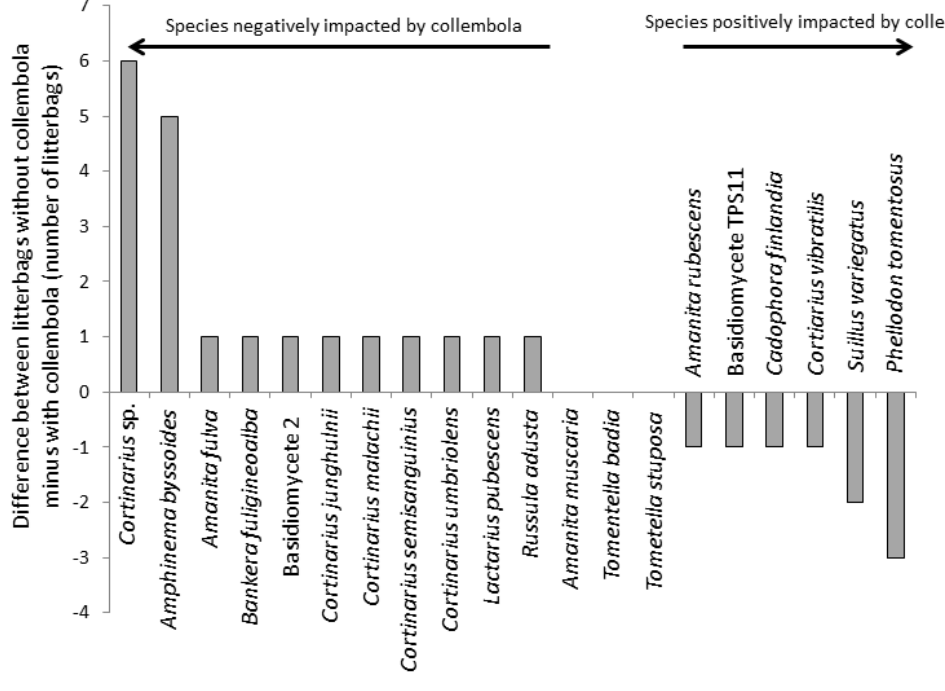
Figure 3. Response of ECM fungal community to collembola grazing in situ . The data show the difference in the number of litterbags without collembola minus the number of litterbags with collembola that contain a particular ECM fungal